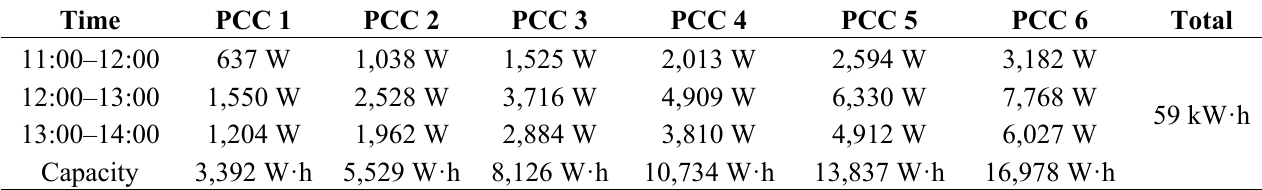
Table 3. ESSs charging schedule and capacity (case 2: most of the PVs are distributed on the upper side).